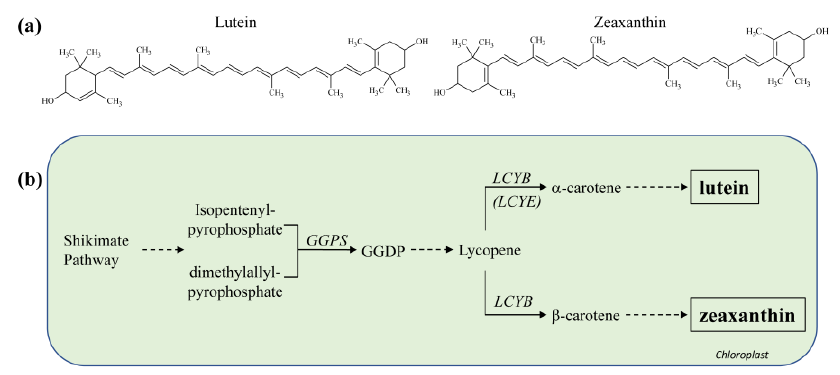
Figure 5. Carotenoid biosynthesis in higher plants. ( a ) Chemical structures of lutein and zeaxanthin. ( b ) Schematic drawing of some of the key steps in chloroplastidic carotenoid biosynthesis via the shikimate pathway. GGDP, geranylgeranyl pyrophosphate; GGPS, geranylgeranyl diphosphate synthase; LCYB, lycopene β -ring hydroxylase; LCYE, lycopene ε -ring